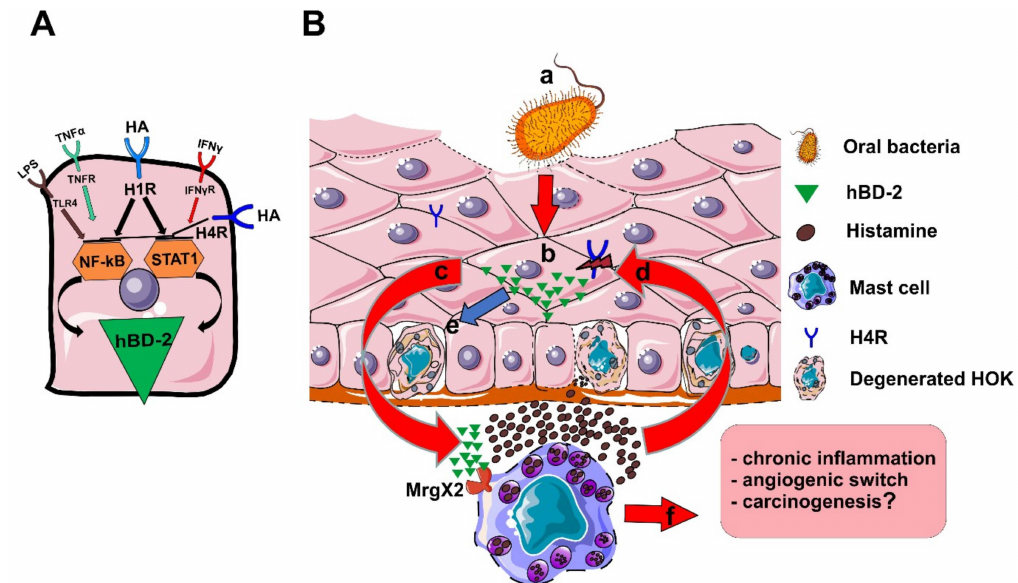
Figure 6. ( A ) The effect of histamine (HA) on hBD-2 production is likely mediated via nuclear factor- κ B (NF- κ B) and, to lesser extent, via signal transducer and activator of transcription 1 (STAT1); hBD-2 promoter region contains two sites for NF- κ B and one site for STAT1, which are both induced by histamine signaling. Effect of H4R on hBD-2 in HOKs could be mediated via both STAT1 and NF- κ B axes. ( B ) The following scenario is proposed to illustrate the role of histamine-BD-2 axis in perpetuation chronicity in OLP: a) bacterial invasion into deeper layer cells is enhanced by the impaired barrier integrity in OLP; b) epithelial cells secrete considerable amounts of hBD-2; c) hBD-2 from epithelial cells stimulates mast cell (MC) degranulation and histamine release via Mas-related gene X2 (MrgX2); d) histamine, in turn, activates oral epithelial cells to produce more hBD-2 and, thus, perpetuates a proinflammatory vicious circle; e) Surplus histamine and hBD-2 may result in further MC degranulation, degeneration of the epithelial cell barrier, and loss of H4R; f) MC degranulation enhances the proinflammatory response by recruiting more immune cells and driving angiogenesis (angiogenic switch), which may partly promote carcinogenesis in OLP